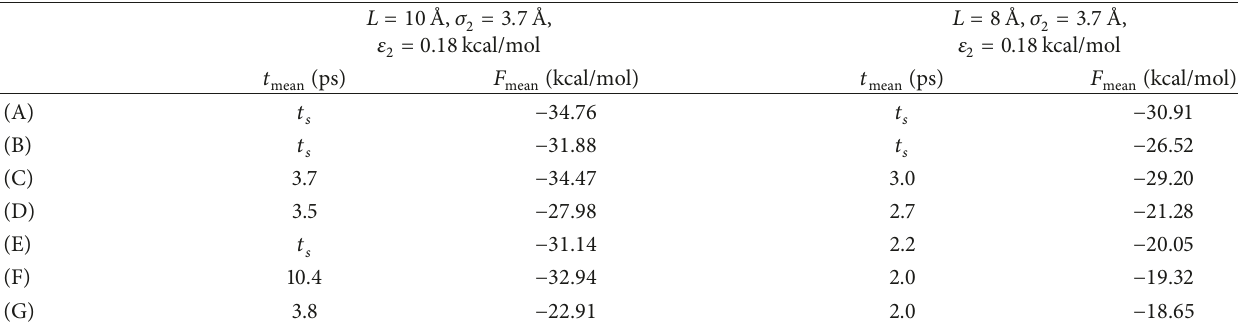
Table 3: The mean residence time ( 𝑡 mean ) and free energy ( 𝐹 mean ) for the different atomic distributions of linear molecules with 𝜎 1 = 2.5 ˚A, 𝜀 = 0.07 kcal/mol, and p = 0.5. 𝑡 1 𝑠 is the simulation time